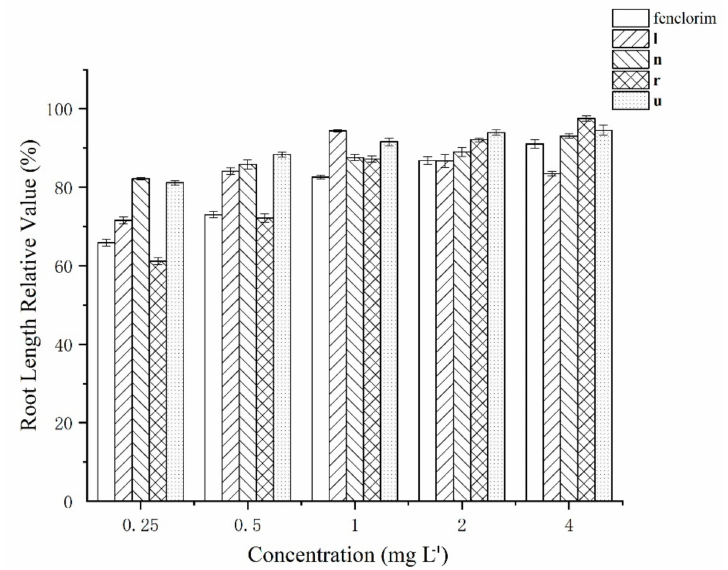
Figure 3. Plant root length relative value of 0.25 µ M metolachlor ( M )-treated rice seedlings treated with compounds 1 , n , r , and u at 0.25 mg L − 1 , 0.5 mg L − 1 , 1 mg L − 1 , 2 mg L − 1 , and 4 mg L − 1